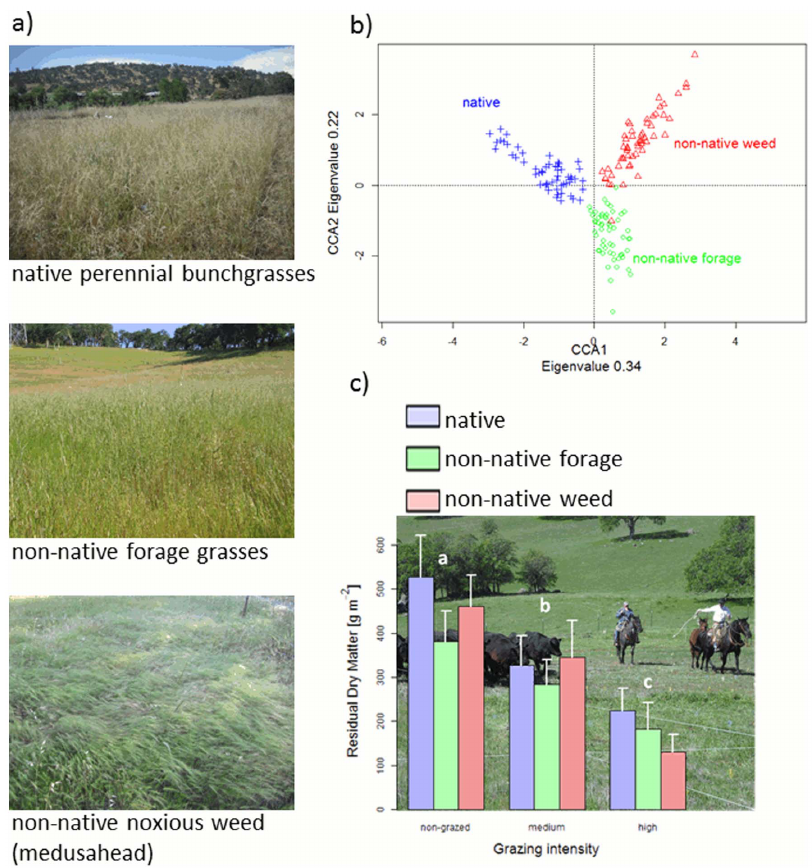
Figure 1. The three grassland species assemblages investigated in this study. The (a) three original planted species assemblages are clearly distinguishable based on their species composition as shown by (b) results of CCA of species abundances from 2008–2010 with year and study site as covariate. (c) Residual dry matter measured in 2010 to describe grazing gradient within the three ecosystem types. Letter above bars indicate significant differences among grazing levels as determined by planned orthogonal contrasts at P ,